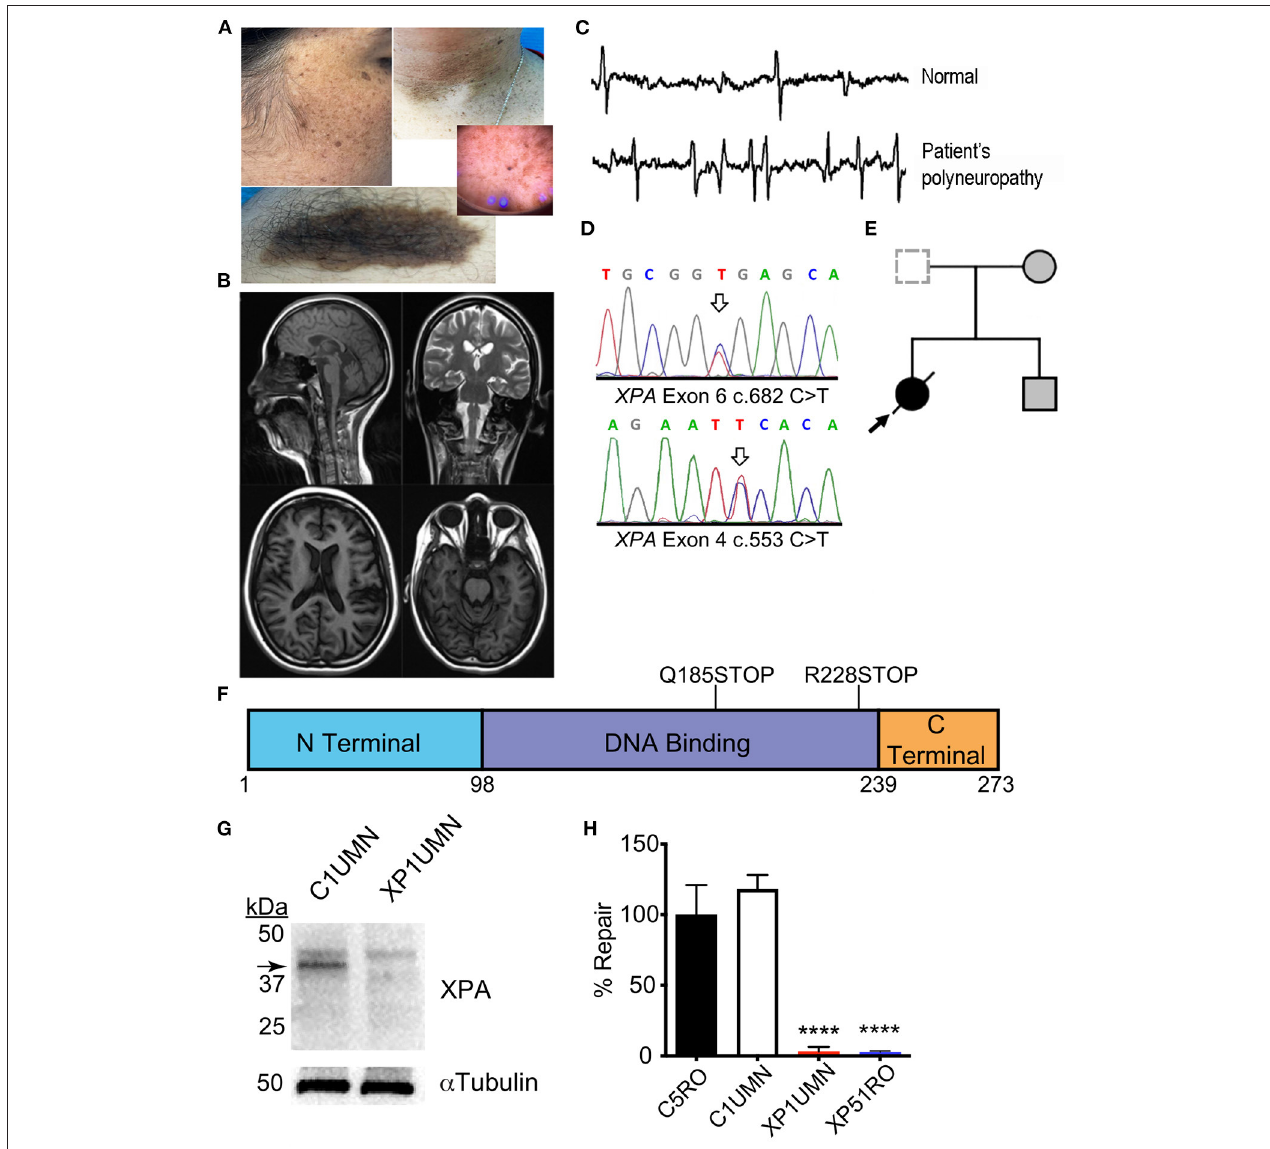
FIGURE 1 | Clinical and functional impact of a known and novel mutation in XPA . (A) Face and arm photographs demonstrating prominent skin freckling or verrucous epidermal nevi. (B) MRI images showing no signs of pathology. (C) Representative image of EMG/nerve conduction tests indicating diffuse axonal sensorimotor polyneuropathy. (D) Sanger chromatogram demonstrating relevant mutations in both XPA alleles from the patient (arrows). (E) Nuclear family pedigree. (F) Location of XPA mutations. Schematic diagram of XPA protein with the functional domains of XPA. Each mutation gives rise to a premature stop codon. The corresponding amino acid numbers are shown below. (G) Mutations cause a loss of XPA in patient fibroblasts. Immunoblotting for XPA in patient dermal fibroblasts from suspected XP-A patient (XP1UMN) and an unrelated control (C1UMN). α -Tubulin was used as a loading control. Arrow denotes the specific band corresponding to XPA. (H) Measurement of UV-induced UDS in patient fibroblasts. Unscheduled DNA synthesis was measured in fibroblast lines, and the relative NER capacity is reported. NER capacity was normalized to those obtained for NER-proficient (C5RO) cells (set at 100%), and NER-deficient (XP51RO) control fibroblasts were used as a negative control. UDS was measured in duplicate for each cell line in three independent experiments. Values represent mean ± SD, **** p < 0.0001 by one-way ANOVA with Tukey’s test. allele of XPA , a c.553C > T mutation in exon 4 (Gln185Ter)